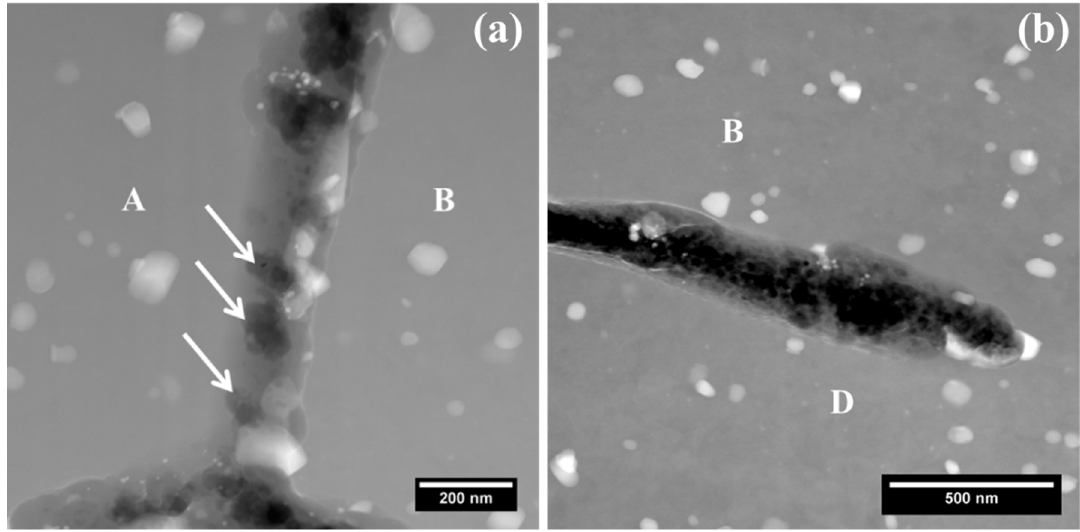
Figure 6. ( a ) HAADF micrograph of boundary A‐B of Figure 4; ( b ) HAADF micrograph of boundary B‐D of Figure 4.